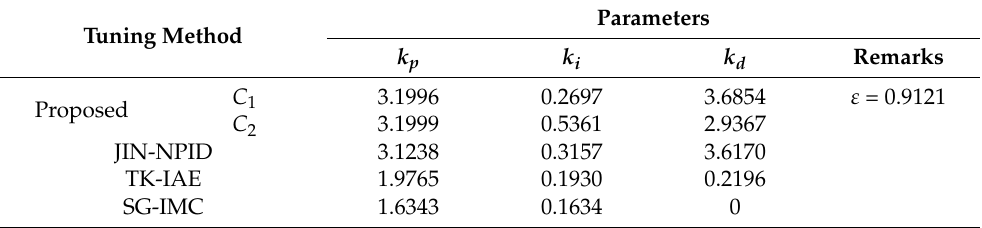
Table 1. PID controller tuning for process 1.